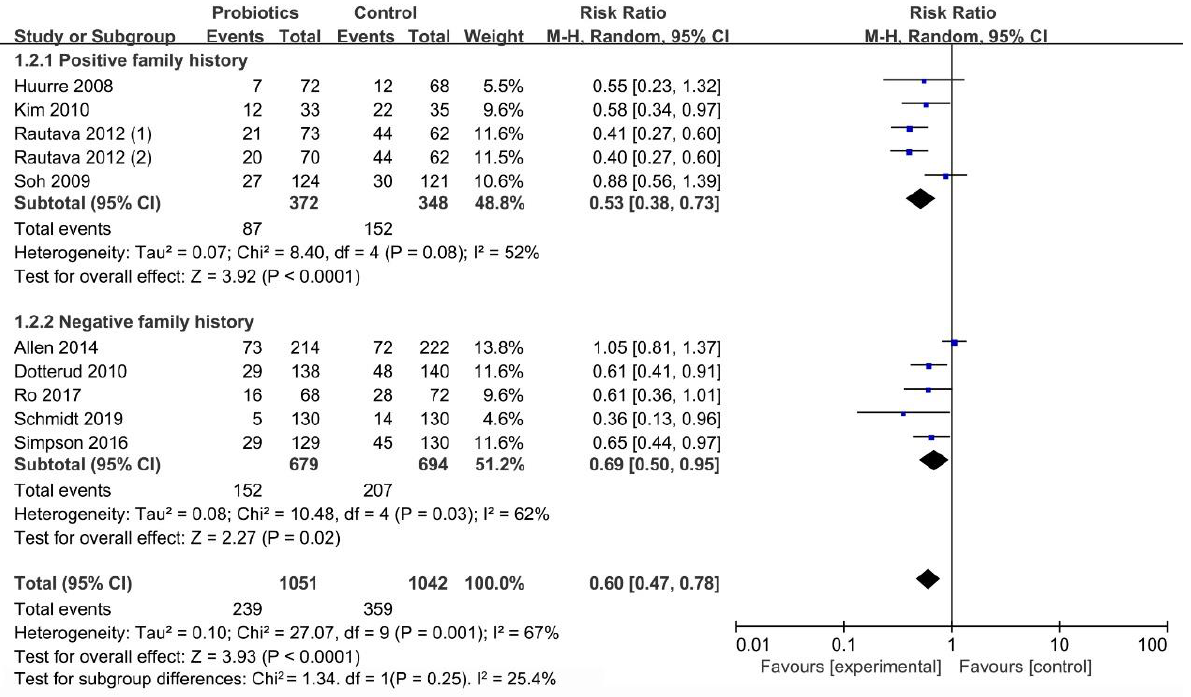
Figure 6. The relationship between mixed strains of Lactobacillus and Bifidobacterium and infant eczema with different family histories.